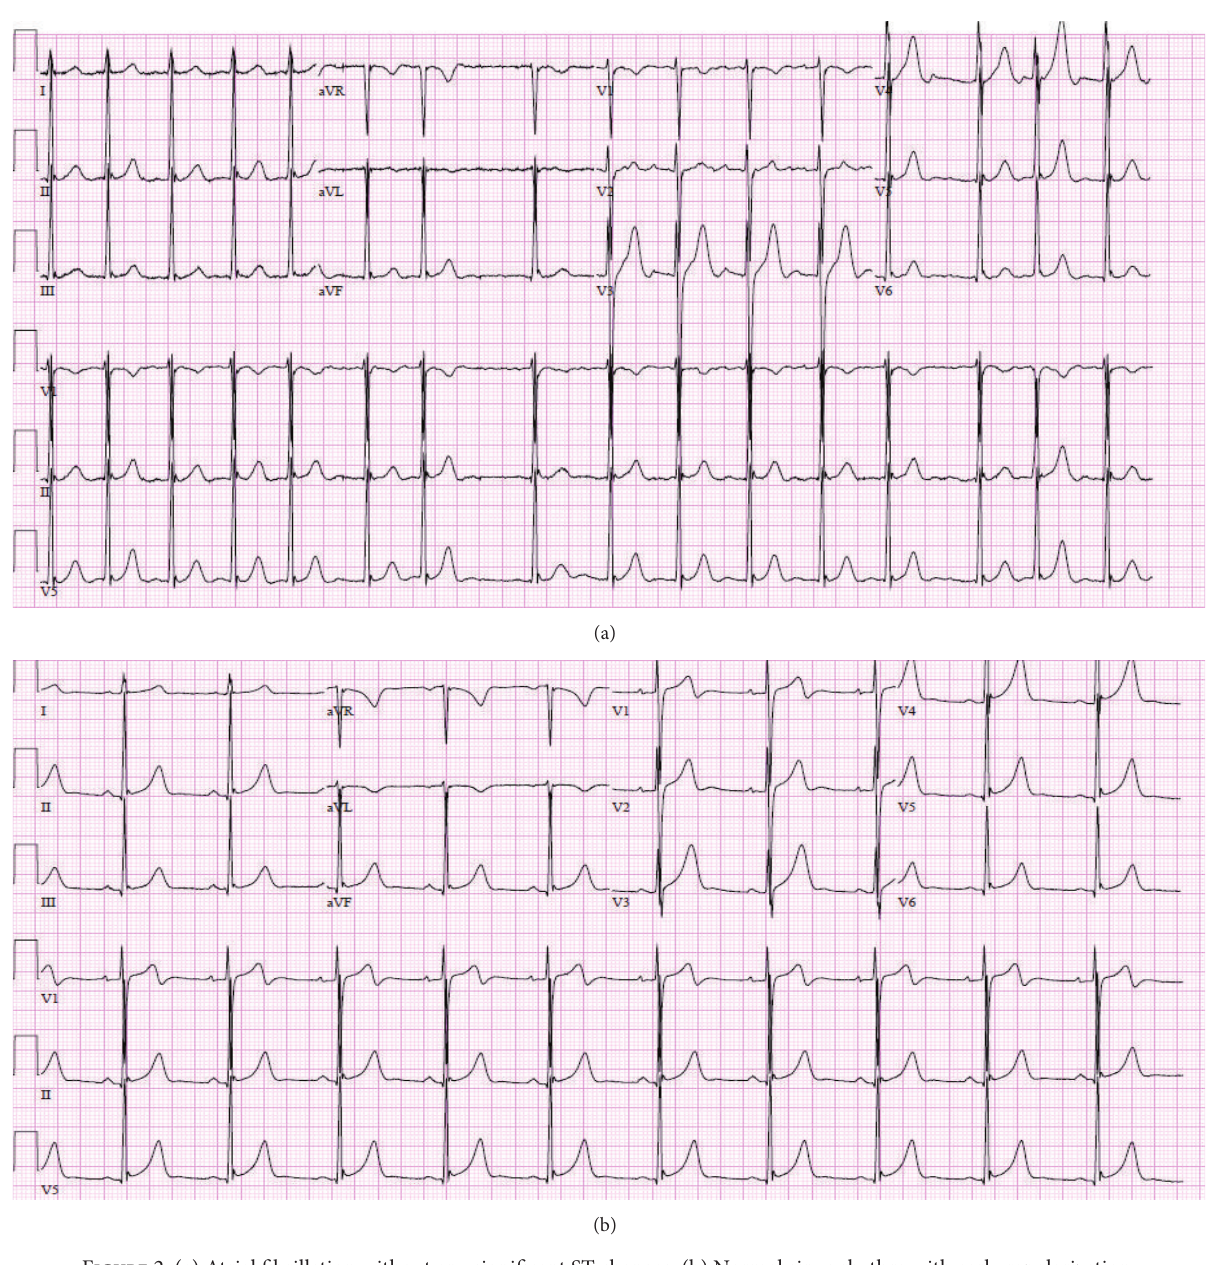
Figure 2: (a) Atrial fibrillation without any significant ST changes. (b) Normal sinus rhythm with early repolarization.